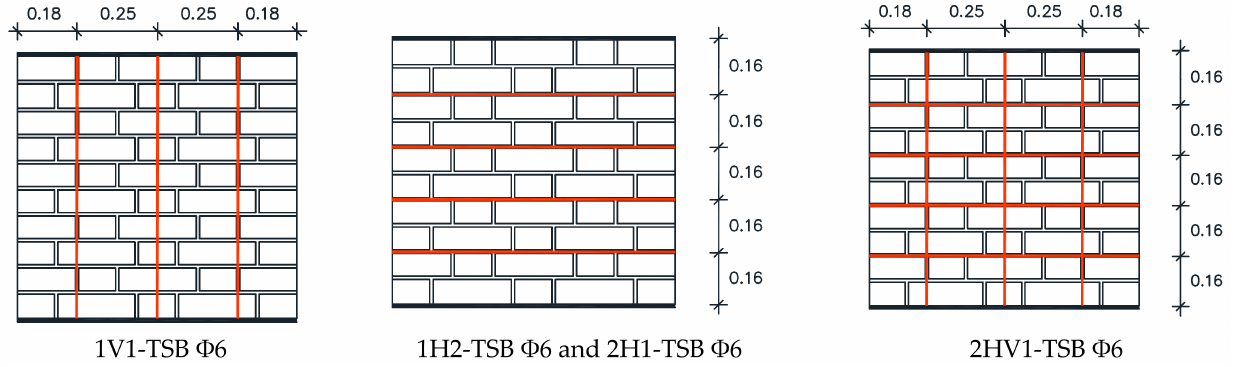
Figure 3. Specimen reinforcement layout with Φ 6 mm TSB (Type 3).